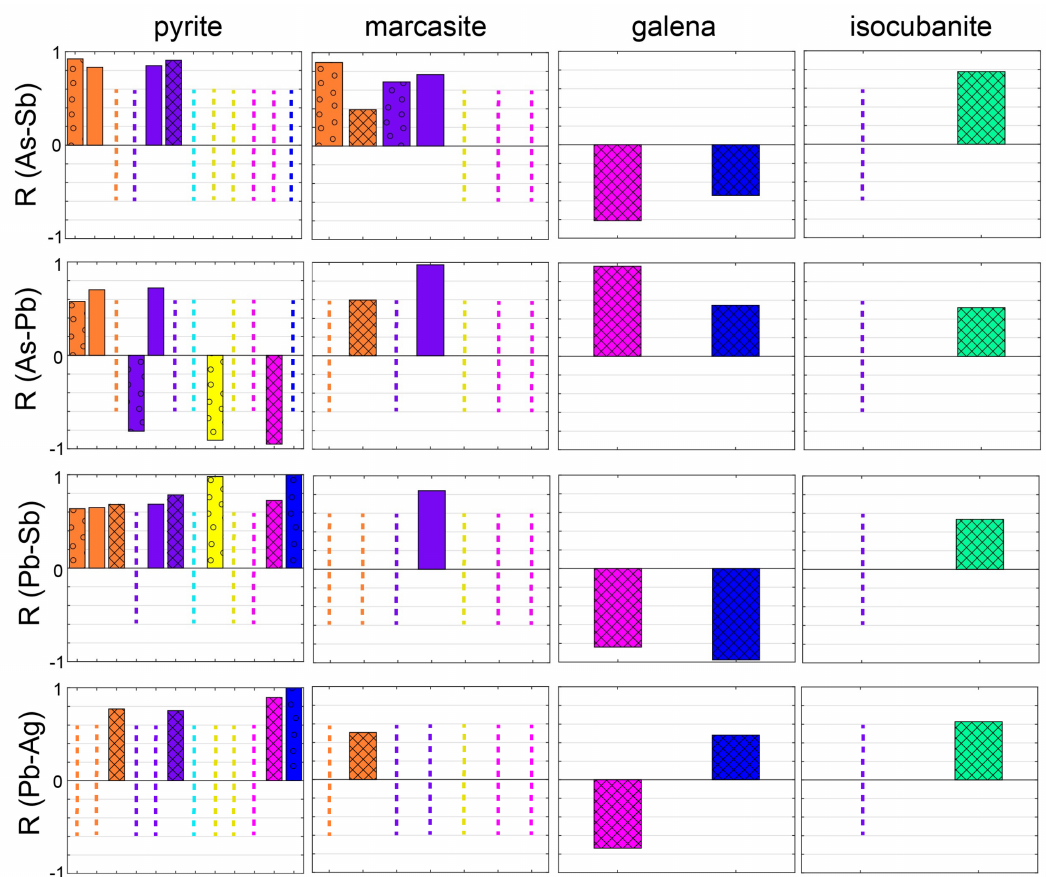
Figure 10. Correlation coefficients (R) for LA-ICP-MS trace data for pyrite, marcasite, isocubanite, and galena categorised by sample suite and texture using the elemental pairs As-Sb, As-Pb, Pb-Sb and Sb-Ag. Colour indicates sample suite where orange: TAG ( Trans-Atlantic Geotraverse ), purple: TP ( Turtle Pits ), cyan: SEPR ( South East Pacific Rise ), yellow: AS ( Axial Seamount ), magenta: PM ( Pacmanus ), blue: PVC ( Palinuro Volcanic Complex ) and green: LOG ( Logatchev ). Patterns highlight texture where circles: colloform, blank: porous and diamond: massive). Dashed lines indicate where any correlation is statistically